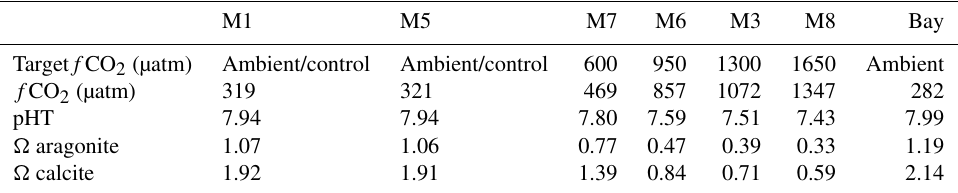
Table 1. Carbonate system parameters in the mesocosms during the experiment (average values on days 0–17, the main settling period of M. balthica ). M1 M5 M7 M6 M3 M8 Bay Target f CO 2 (µatm) Ambient/control Ambient/control 600 950 1300 1650 Ambient f CO 2 (µatm) 319 321 pHT (cid:127)